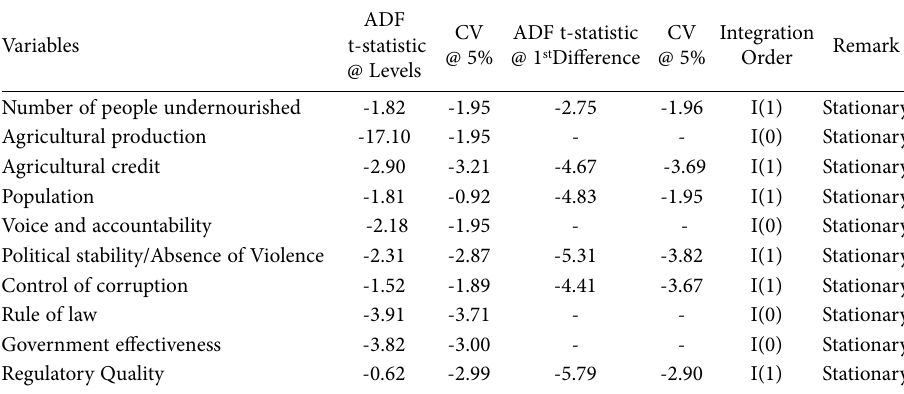
Table 2. Unit Root Test for